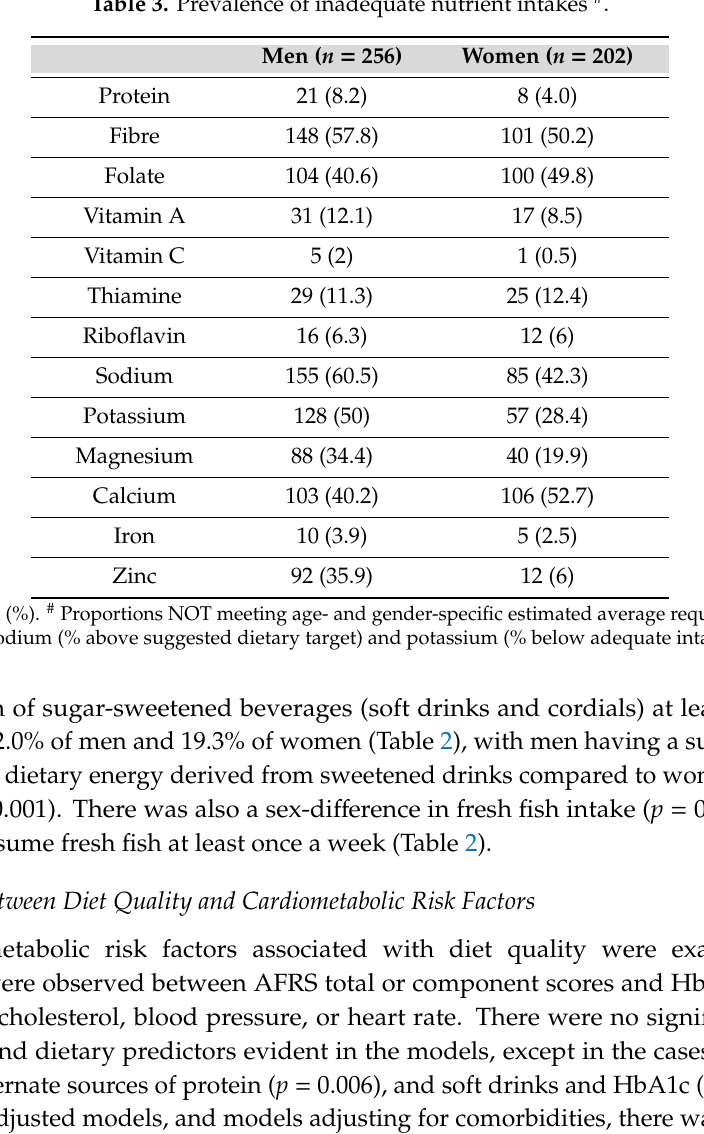
Table 3. Prevalence of inadequate nutrient intakes #